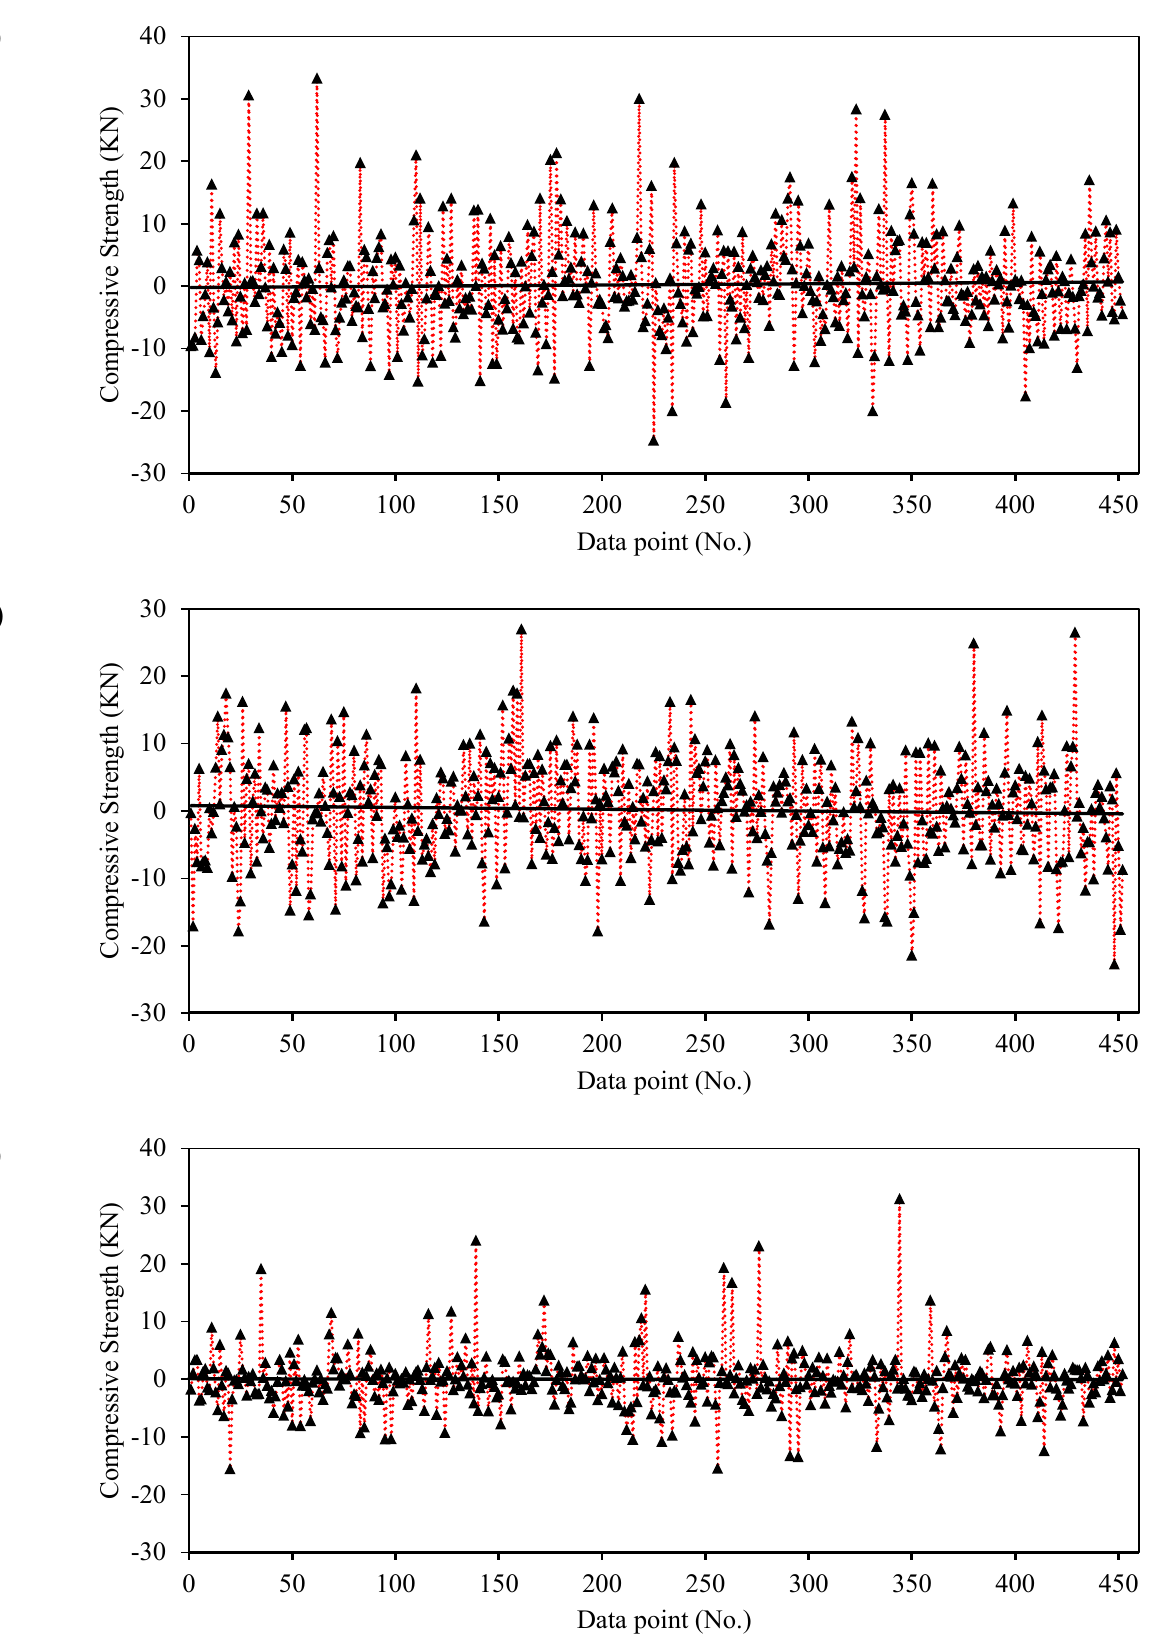
Figure 10. Error analysis: ( a ) ANFIS, ( b ) GEP, and ( c ) GBT.